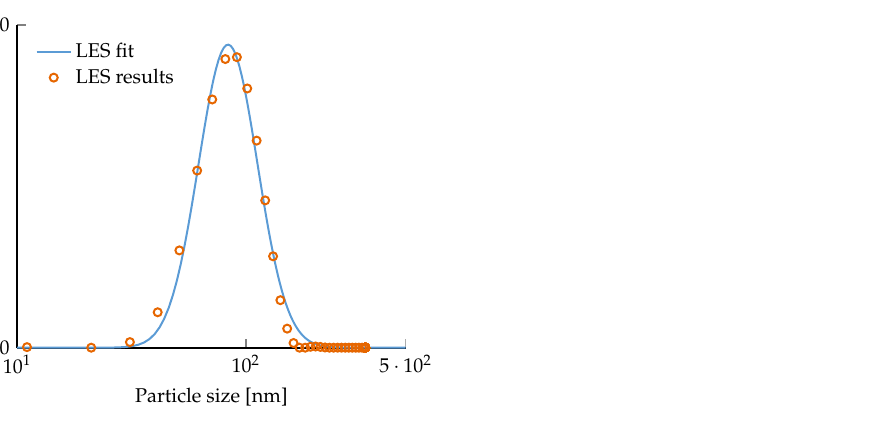
Figure 3. Particle size distribution of TiO 2 –water nanofluid at 0.2 wt.% measured by the LES technique. A log-normal fit of the experimental results gives the median diameter of 70.1 nm with a non-dimensional dispersity level of 0.3. Table 3. Measured rheological properties of the water and water-based TiO 2